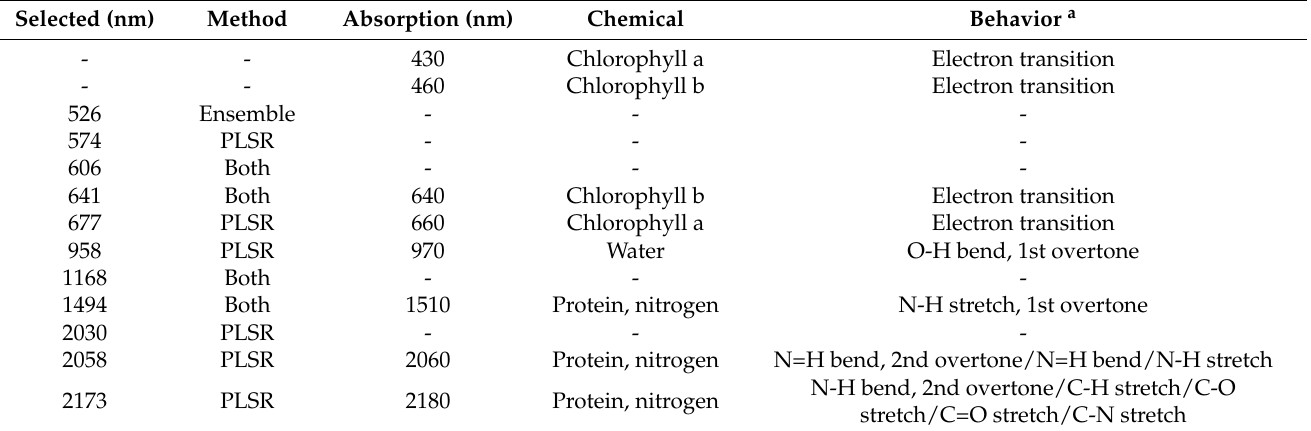
Table 2. Selected wavelengths for nitrogen and the known nearby absorption features.